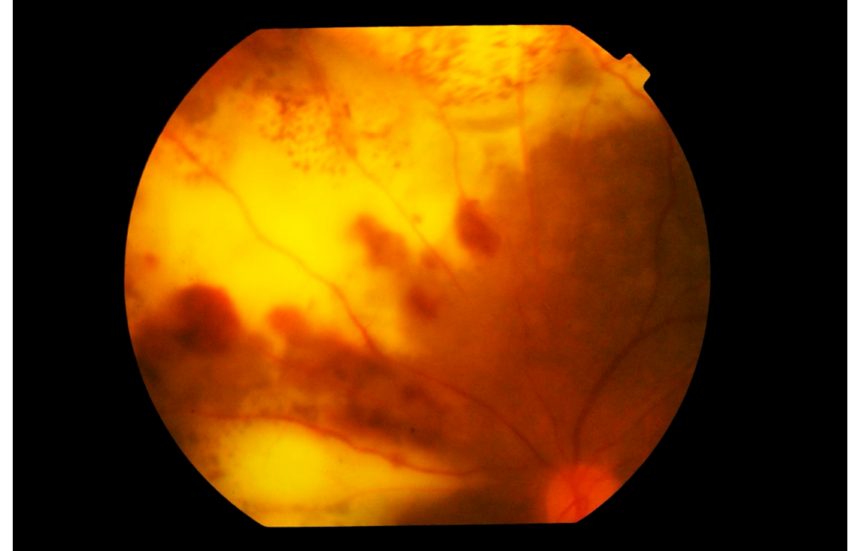
Figure 6. Photograph of the left superior nasal fundus showing large confluent yellowish subretinal infiltration by lymphoma cells. Large blotches of retinal hemorrhage are also observed, creating a picture of deep retinal necrosis. Note that the vitreous is clear and the disc is not swollen. Uncommonly, VRL may present with multiple small punctate whitish lesions dis- tributed over the fundus at the outer retina/RPE level, and may be mistaken for multiple evanescent white dot syndrome [69,70]. Typically, minimal or no macular edema is